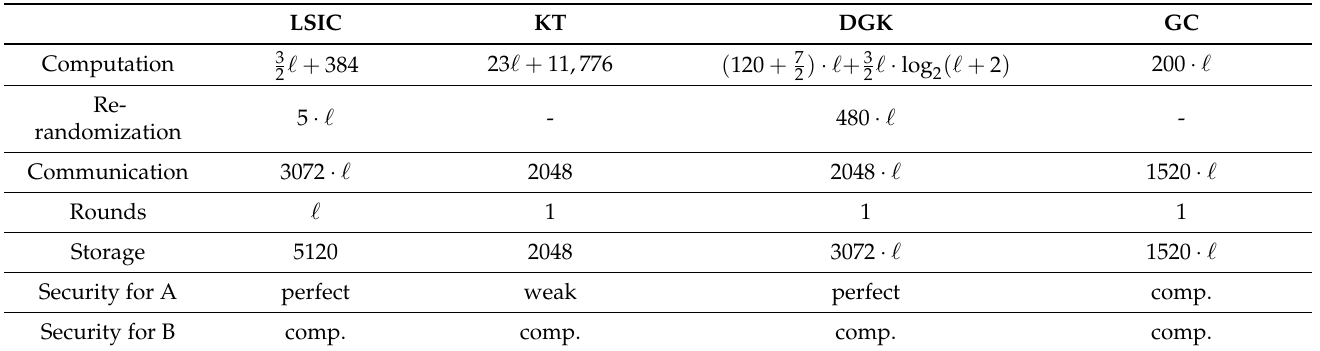
Table 4. Complexity analysis of related